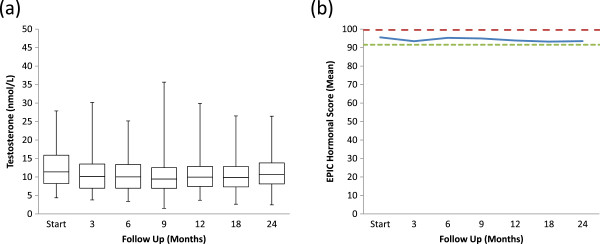
Pre- and post-treatment testosterone levels and EPIC hormonal scores. (a) Box-and-Whisker plot of total testosterone levels. The p values were from χ2-analysis with baseline testosterone levels. (b) Average EPIC hormonal scores. Thresholds for clinically significant changes in scores (½ standard deviation above and below the baseline) are marked with dashed lines. EPIC scores range from 0–100 with higher values representing a more favorable health-related QOL.